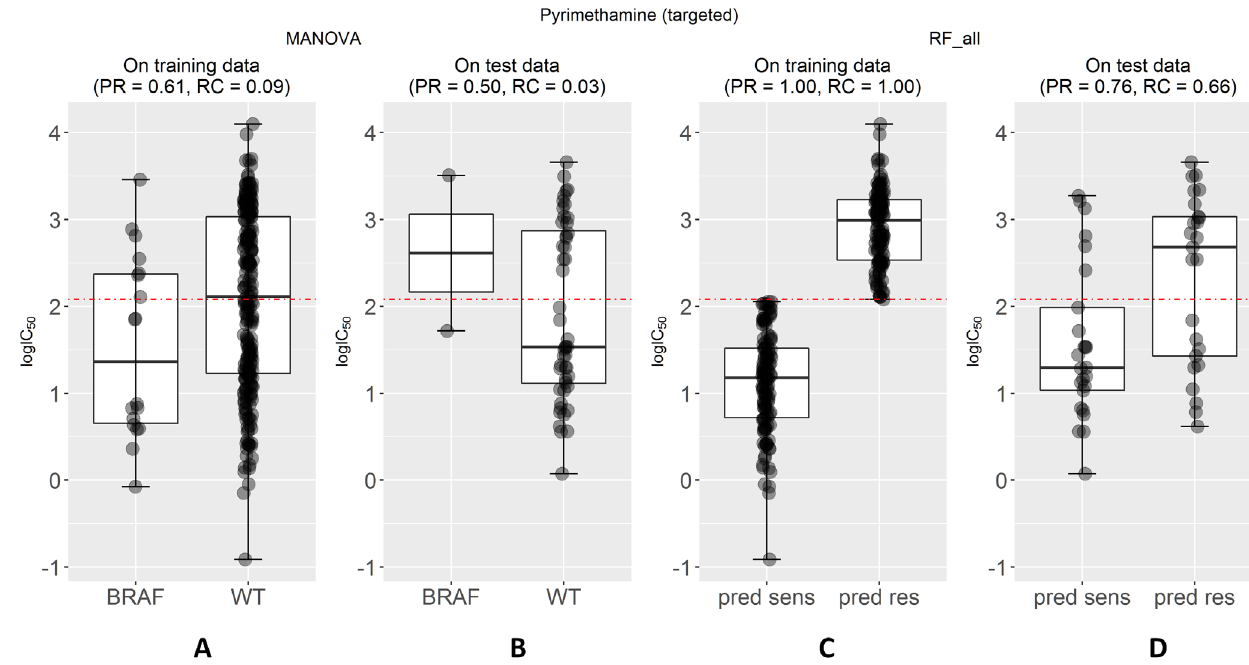
Figure 1. Predictive performance of markers of cell sensitivity to the approved drug pyrimethamine. ( A ) The single-gene marker with the lowest p-value on the training set was the pyrimethamine-BRAF sensitising association (P=0.002) 8 . ( B ) The boxplots show the sensitivity of cell lines on the independent test set for pyrimethamine depending on whether these harbour mutations in the BRAF gene or not (WT). Using this marker, BRAF-mutant cell lines are predicted to be sensitive to this drug (i.e. below the threshold in red established with training data), but the prediction is worse than random (Matthews Correlation Coefficient (MCC)=-0.03) with its recall being particularly poor (RC=0.03) and average precision (PR)=0.50. ( C ) The multi-gene marker RF_all was built using Random Forests (RF) and all the gene expression values on exactly the same drug-cell pairs as the single-gene markers. ( D ) On the test set, the RF classifier achieves a substantially better performance than single-gene markers (MCC=0.36 vs -0.03) with PR=0.76 and